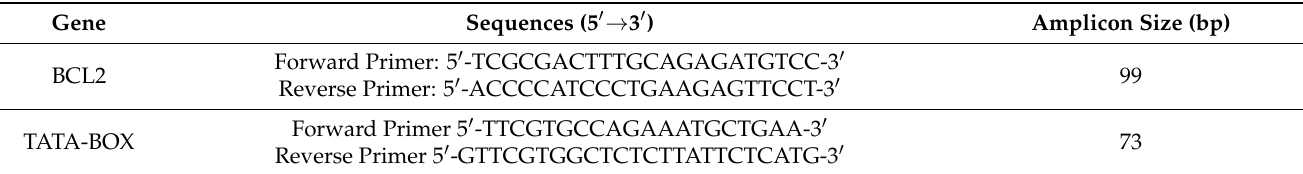
Table 1. List of gene primer